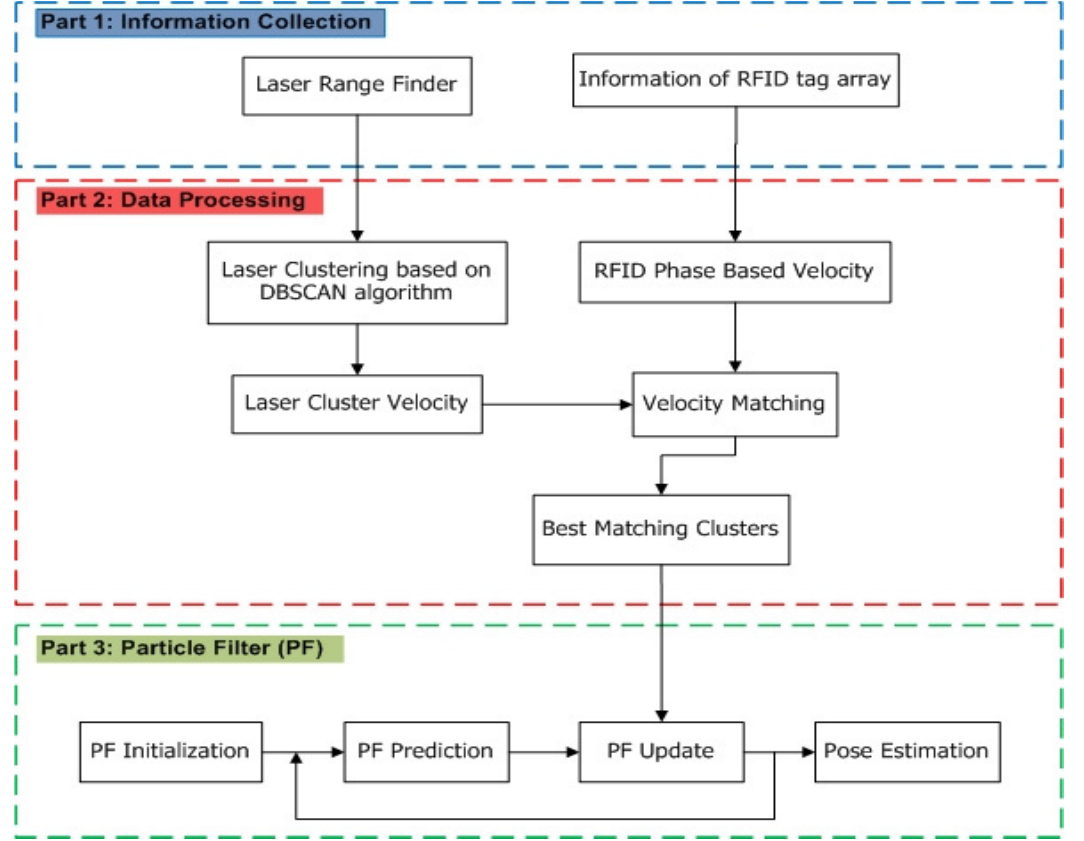
Figure 1. System flowchart giving a brief overview of the system.